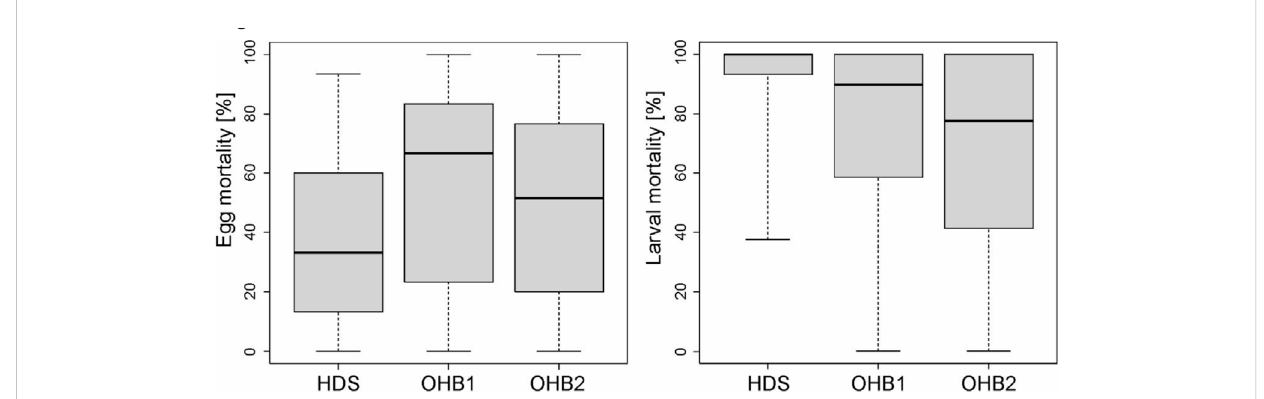
FIGURE 3 Box-whisker-plots (25% quantile, median. 75% quantile, whisker: minimum and maximum values, circles represent outliers) of egg and larval mortality [%] at the three different spawning grounds in the Längenmühlbach (HDS) and the Ottheinrichbach (OHB 1 and OHB 2).